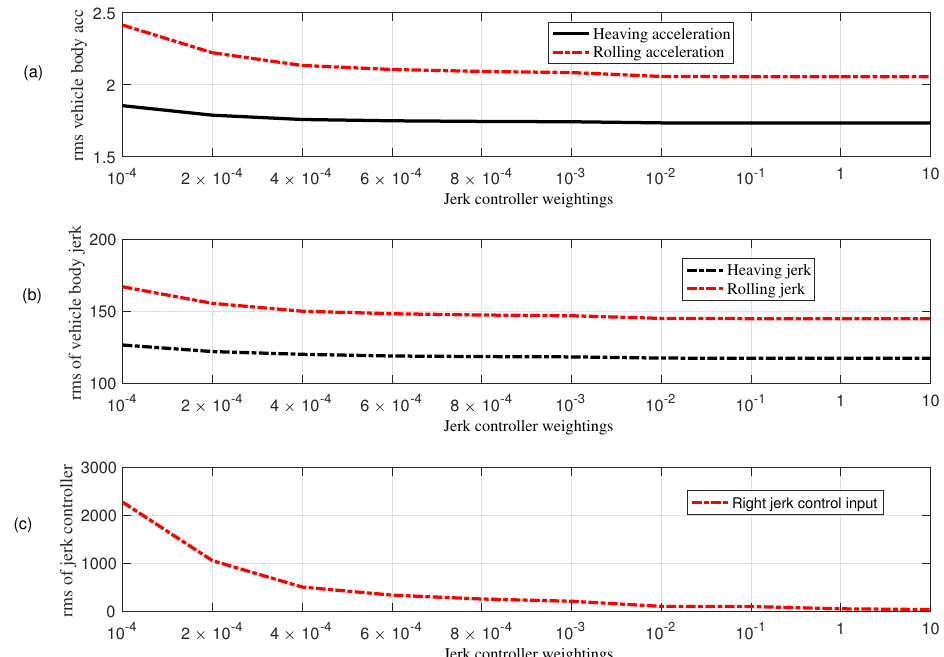
Figure 3. Comparison based on rms values obtained using different weights in the presence of bump velocity input; ( a ) vehicle body acceleration ( b ) vehicle body jerk ( c ) jerk of active aerodynamic surfaces.